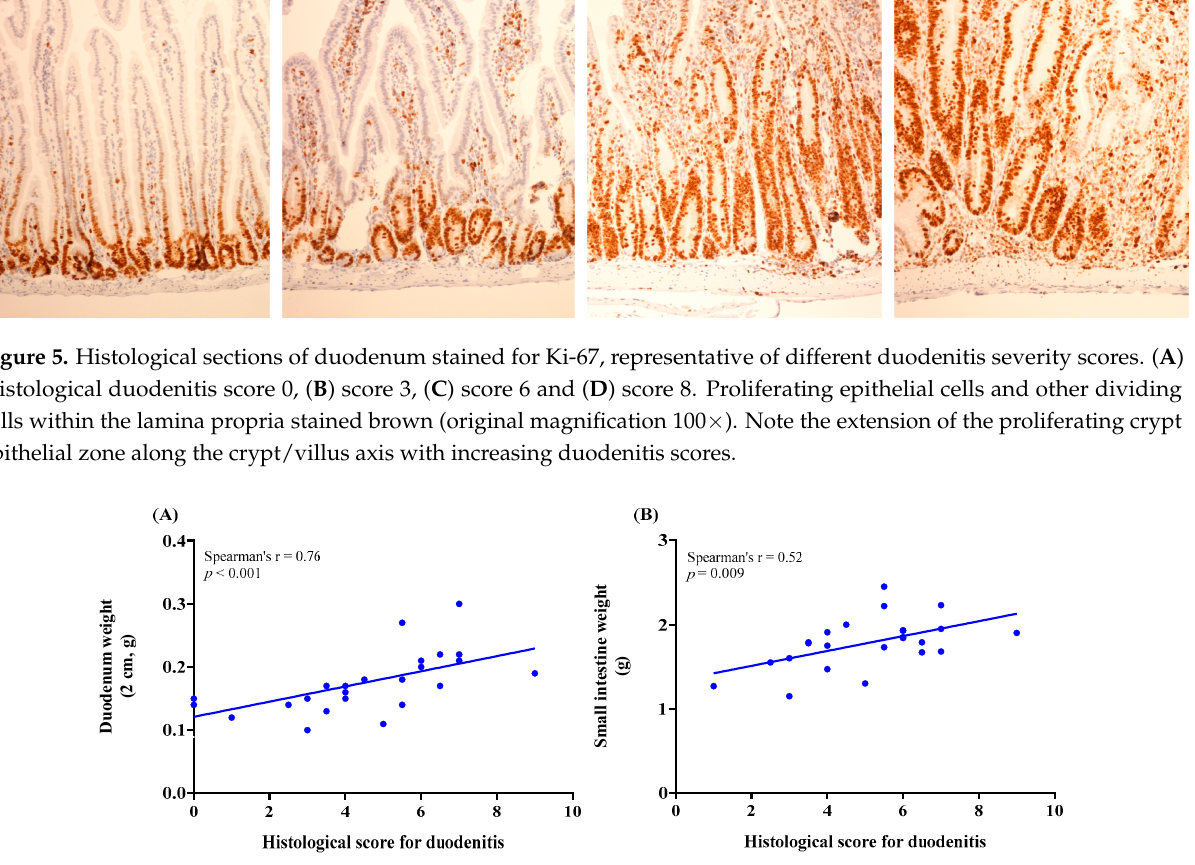
Figure 6. Spearman’s rank correlation coefficient between the histological score for duodenitis and the weight of ( A ) the duodenum and ( B ) the total small intestine in treated and control mice combined.